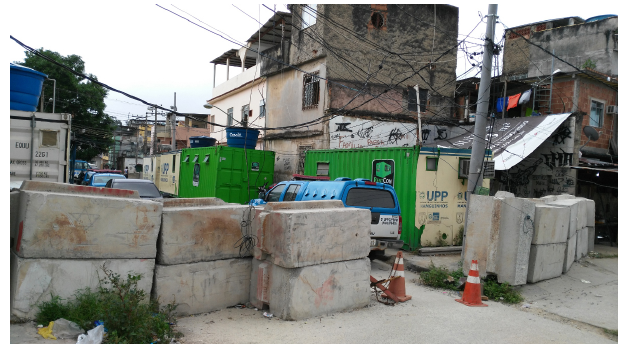
Figure 4. UPP unit headquarters in Manguinhos, fortified with cement